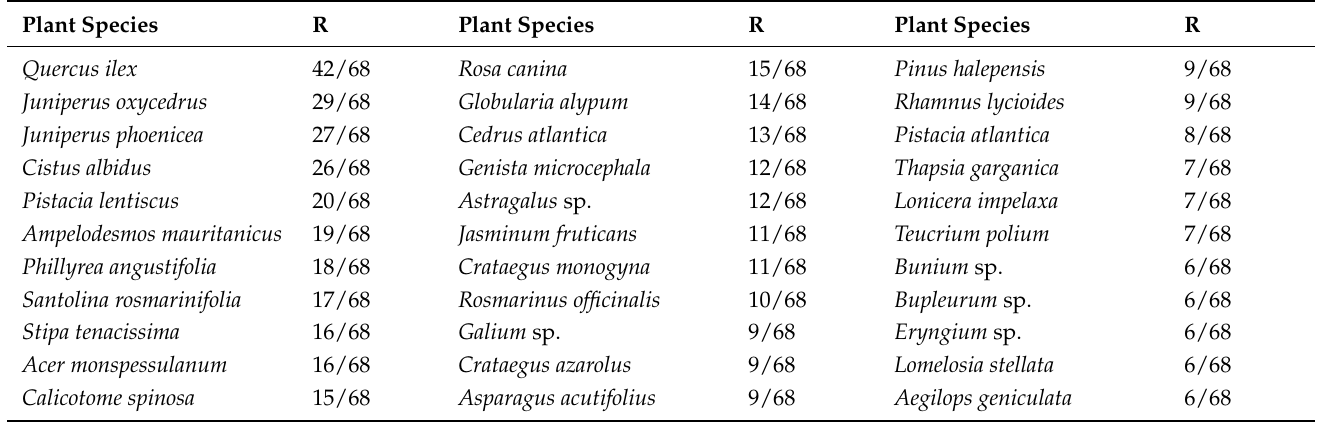
Table 5. Main species identified in the forest of Ouled Hann è